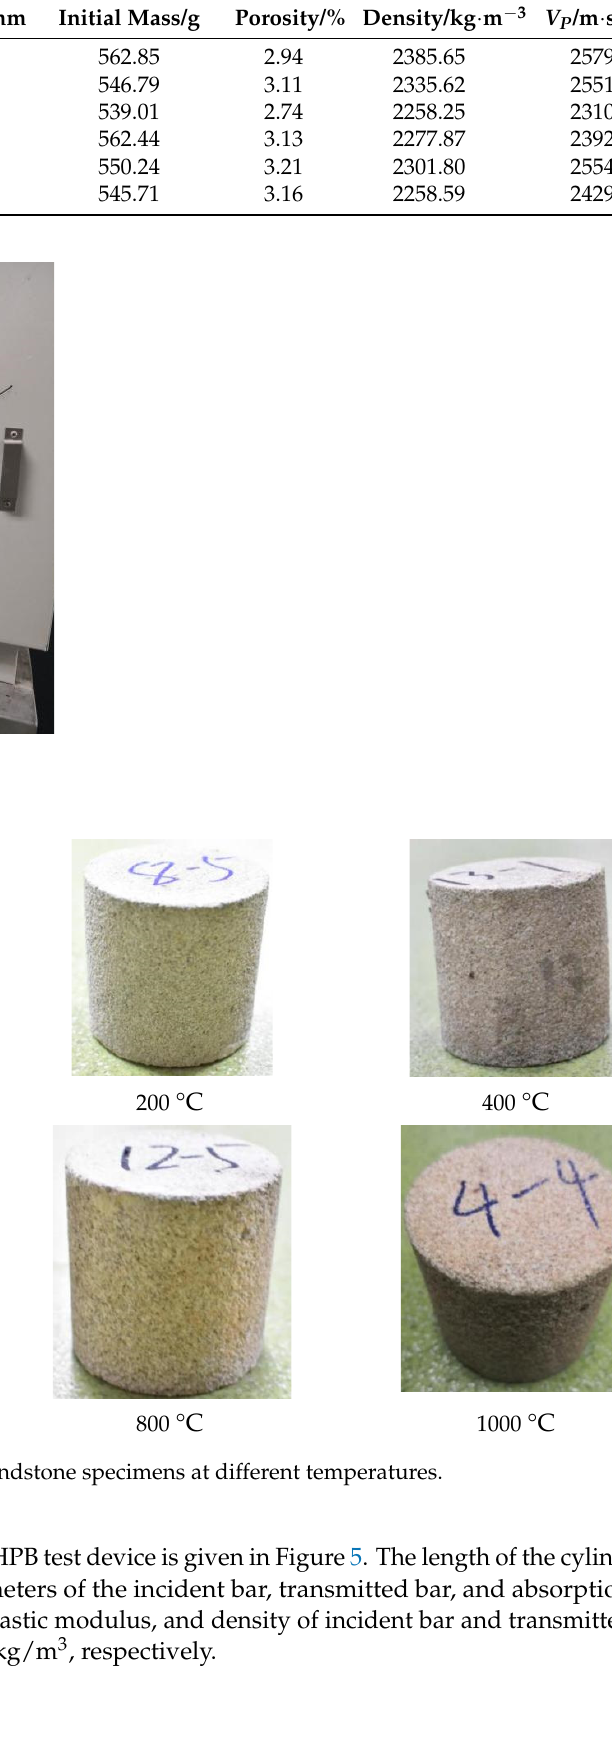
Figure 5. SHPB test system. Figure 6 shows the placement of sandstone specimens during impact test. According to one-dimensional and stress uniformity assumption, when the bullet in the launch cavity hits the incident bar, stress wave propagates in the incident bar and reaches the contact surface between the incident bar and specimen. At this time, a part of the stress wave is reflected, and the other part of the stress wave passes through the specimen and reaches the contact surface between the specimen and transmitted bar. Wave refracts back and forth in the specimen until the stress on both ends of the specimen tends to be uniform.